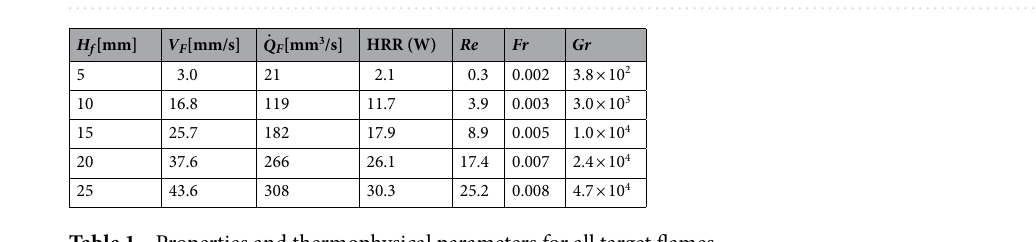
Table 1. Properties and thermophysical parameters for all target